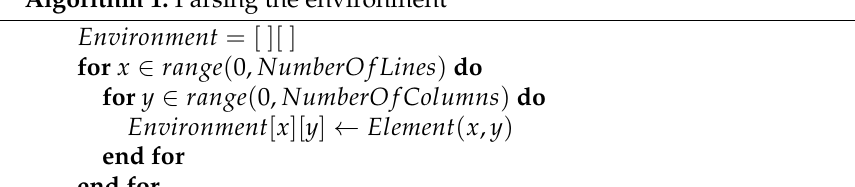
Algorithm 1: Parsing the environment